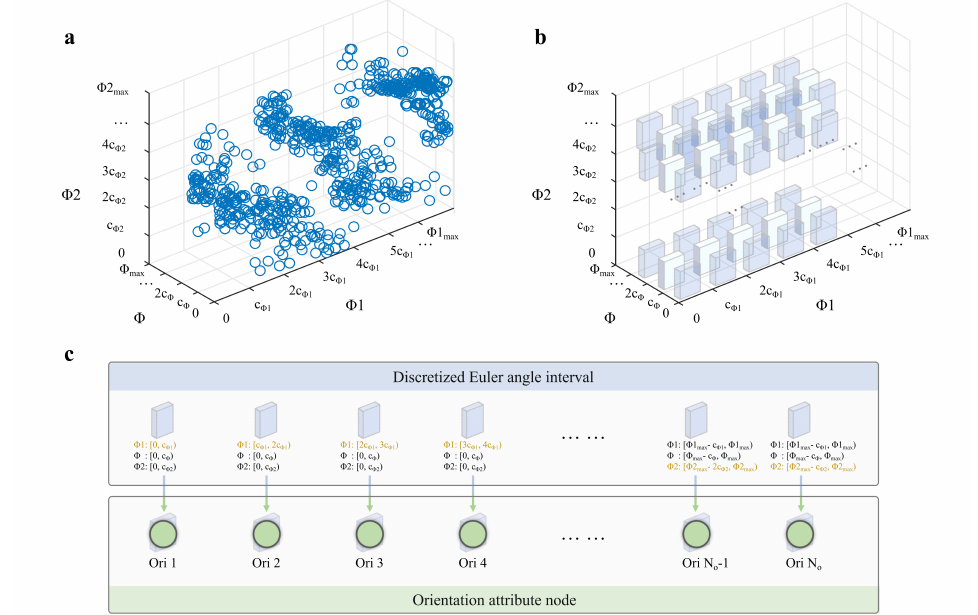
Figure 4. Grain orientation discretization and orientation attribute node construction. ( a ) Simulated Euler angle data distribution. Each orientation is determined by three Euler points. ( b ) The three- dimensional orientation space is discretized, and each orientation point can be divided into a discrete three-dimensional space. ( c ) For each discrete three-dimensional space, the corresponding orientation attribute node is